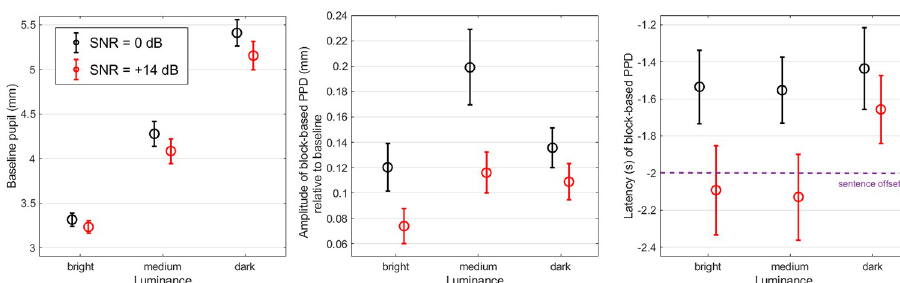
Fig 4. Pupil metrics in Experiment 2. Three pupil metrics, namely baseline (left), PPD amplitude (middle) and latency (right), extracted from block-averaged pupil traces recorded in experiment 2. Error bar represents 1 standard error from the